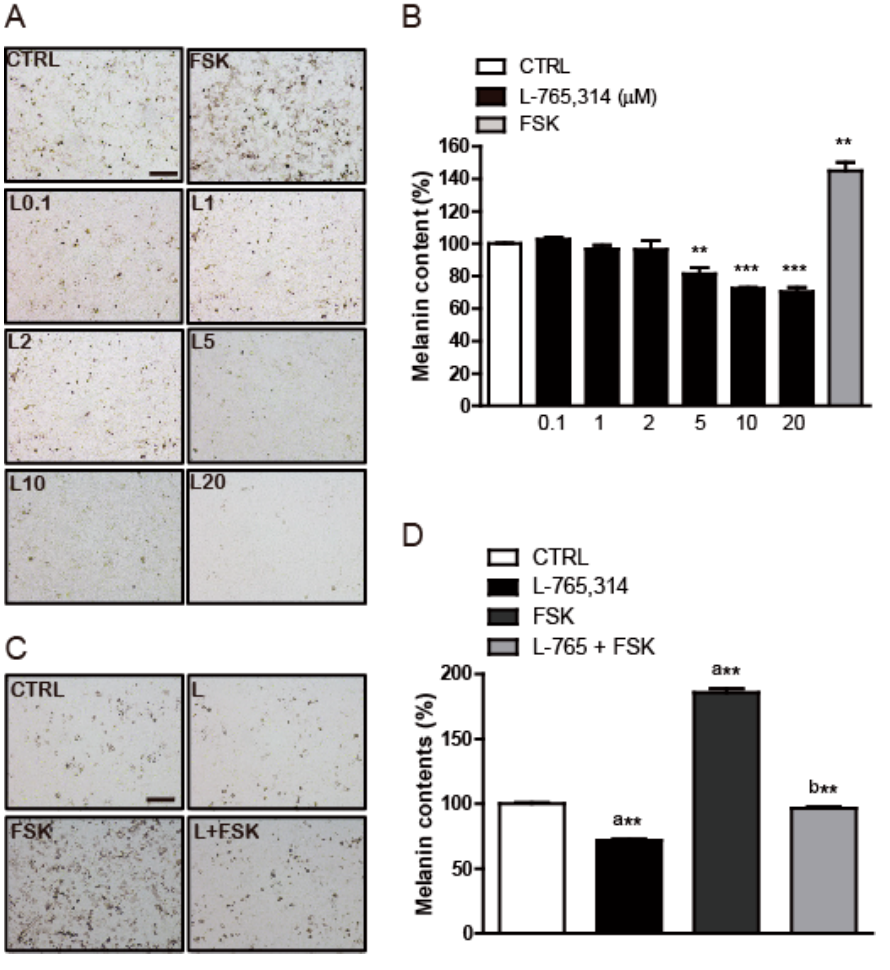
Figure 1. L-765,314 reduced melanin secretion in B16F10 melanoma. ( A ) B16F10 melanoma cells were treated with vehicle or 0.1–10 µ M L-765,314. Seventy-two hours after treatment, the melanin secreted from B16F10 cells was examined. Melanin content is given as percent change relative to vehicle-treated controls. ( B ) Chemical structure of L-765,314 (Benzyl ( S )-4-(4-amino-6,7-dimethoxyquinazolin-2-yl)-2-(tert-butylcarbamoyl) piperazine-1-carboxylate). *** represents p < 0.001.